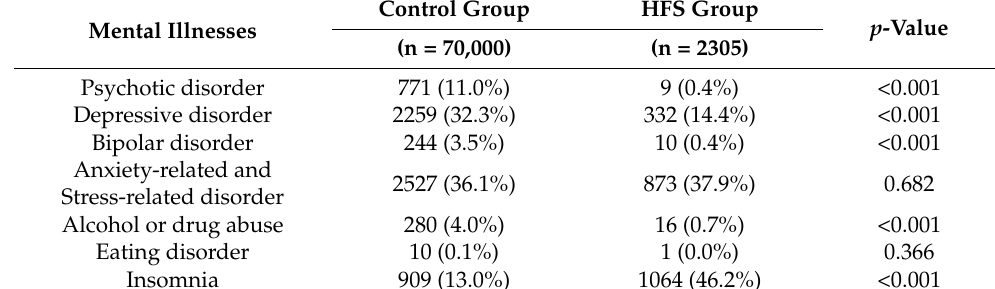
Table 3. The frequency of mental illnesses among the patients with HFS and the control group.